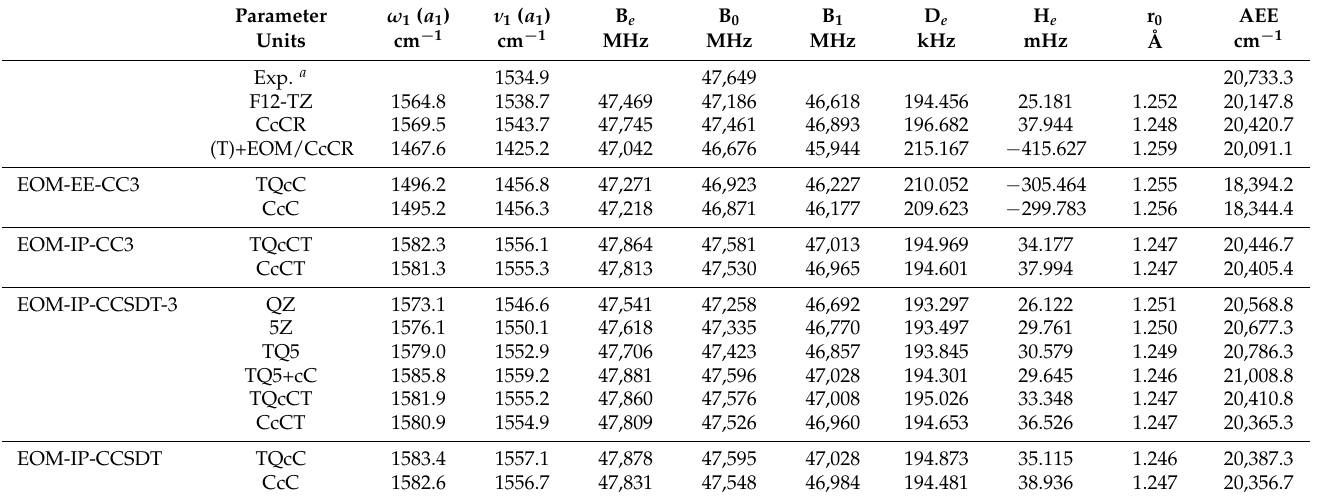
Table 2. Ã 2 Π CO + Vibrational Frequencies, Distortion Constants and Geometrical